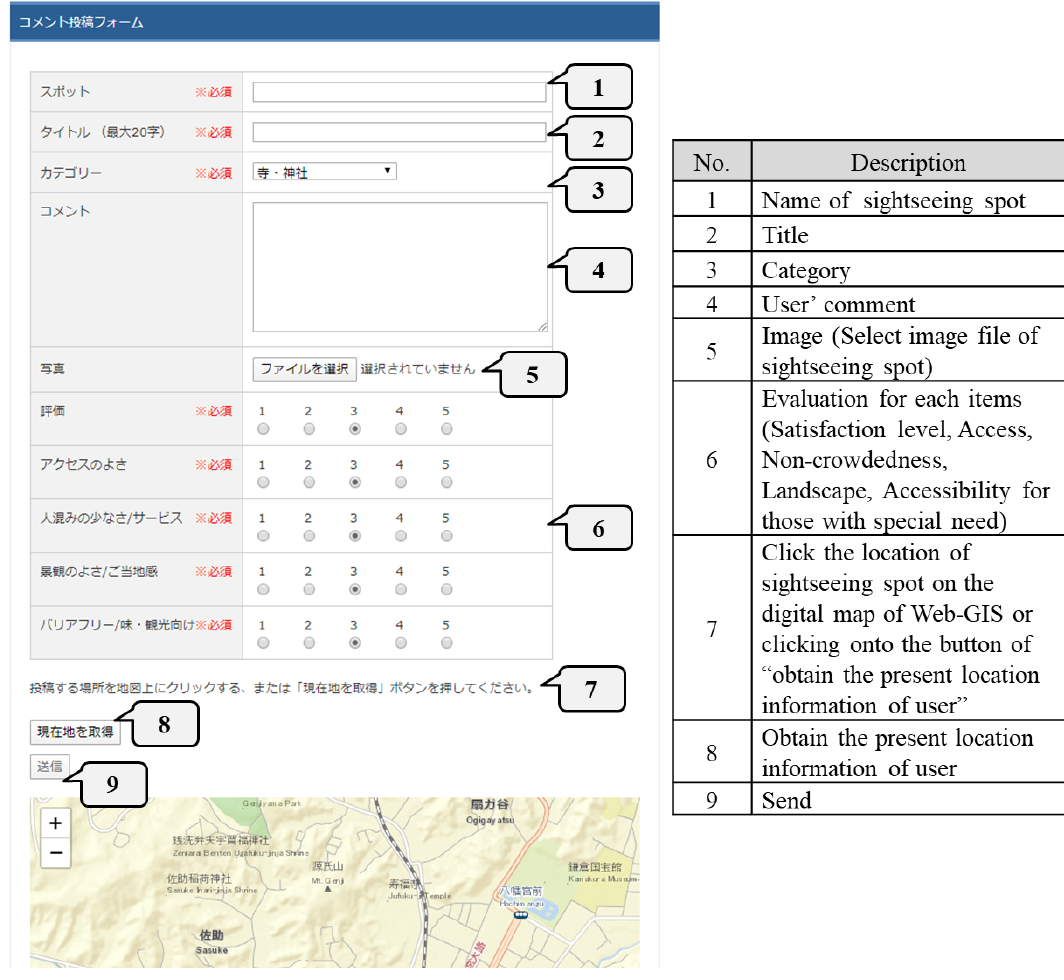
Figure 5. Page for submitting function of sightseeing spots.